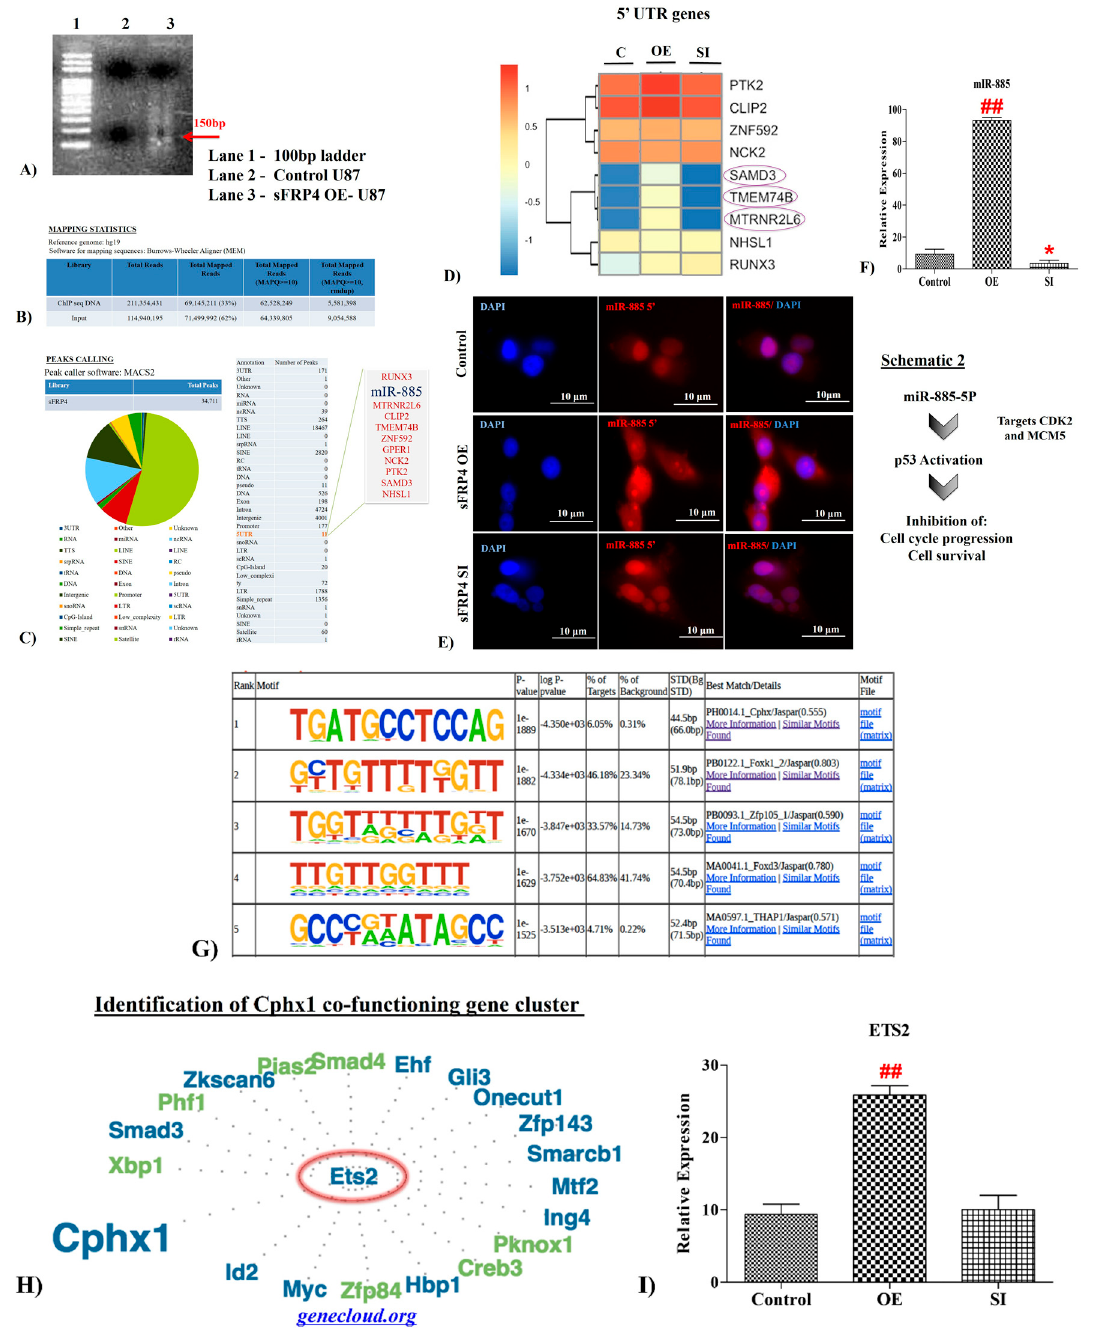
Figure 1. ( A – F ). Apoptosis related genes identified in sFRP4 chromatin immunoprecipitation (ChIP) and pull-down sequencing analysis. Schematic 1 represents the sequence of steps of ChIP and downstream sequencing. ChIP DNA resolved on agarose gel indicated a 150 bp DNA band ( A ), ChIP mapping statistics by Burrow-Wheeler Aligner software indicated 5,581,398 mapped reads ( B ); peak calling analysis output using MACS2 software revealed 34,711 peaks related to secreted frizzled-related protein 4 ( sFRP4 ) ( C , left panel), categorization of peak identities represented by pie chart and table, analysis gene list present within 5 ′ UTR (enlarged) indicated the presence of miRNA 885 ( C , right panel), RNA sequencing data of 5 ′ UTR revealed an upregulation of three 5 ′ UTR genes in sFRP4 OE (OE) and downregulation in sFRP4 SI (SI) cells as indicated in the box ( D ), upregulation of active miR-885 in sFRP4 OE cells using an miR-885 5 ′ LNA probe was detected as red fluorescence using a fluorescence microscope (scale bar = 10 µm) ( E ), quantitative RT-PCR indicated an over expression of miR885 in sFRP4 OE and downregulation in sFRP4 SI cells ( F ). Schematic 2 represents a model indicating the mode of action of miR-885 through its target genes CDK2 and MCM5 in cellular